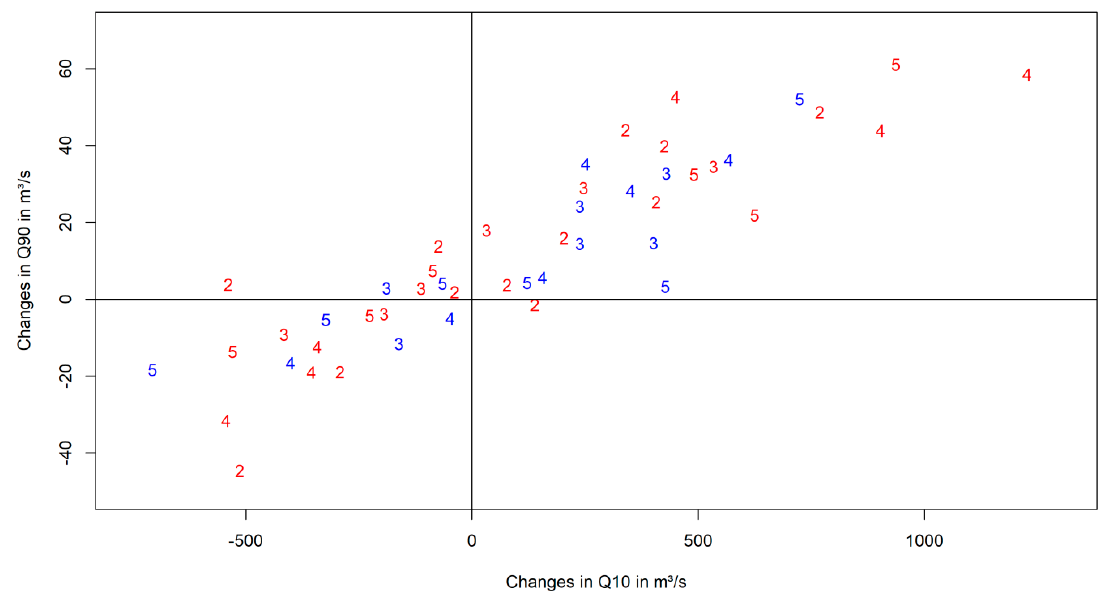
Figure 12. Boxplots showing the distribution of Q10 ( a , b ) and Q90 ( c , d ), representing the flow exceeded in 10% or 90% of the time for Q10 and Q90, respectively. The data in the left columns ( a , c ) is based on the model runs within the RCP4.5 scenario from 2010 to 2060, whereas the right columns display the modeling results within the RCP8.5 scenario. The dashed blue lines represent the measured historical Q10 and Q90 from 1958 to 1970 and the dashed red line represent the modeled historical Q10 and Q90 according to CORDEX Africa from 1951 to 2005, respectively.